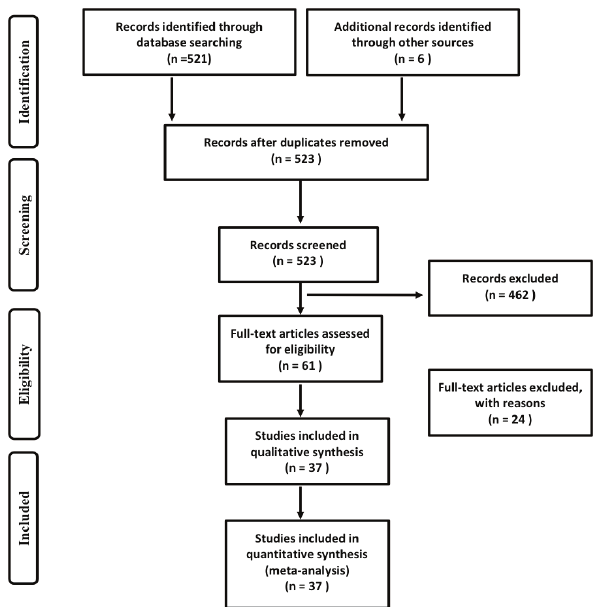
Figure 1: The flowchart of publication searching and